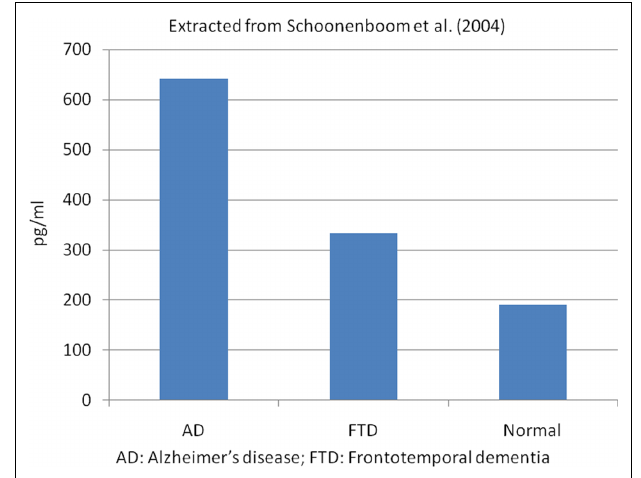
FIGURE 1 | Mean CSF total tau levels in autopsied proven cases. Extracted from Schoonenboom et al. (2004). AD, Alzheimer’s disease; FTD, frontotemporal